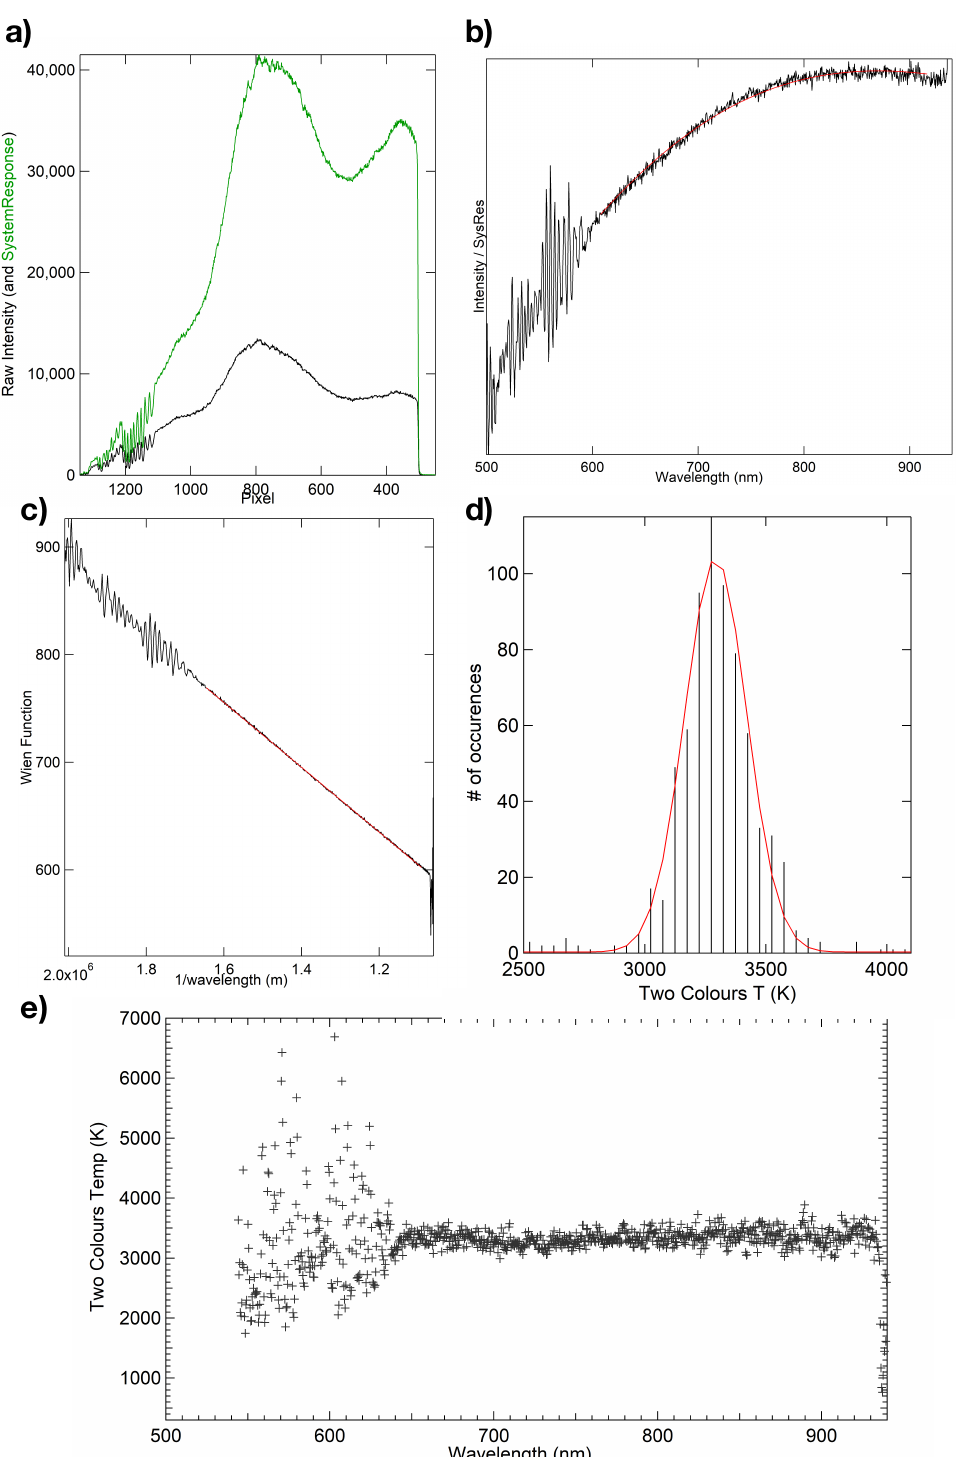
Figure 5. Example of a spectral radiometry temperature measurement obtained around 3300 K. In particular: ( a ) shows the calibrated system response (green) and the raw measurement (black); ( b ) shows the obtained Planck and ( c ) Wien functions and ( d ) the histogram of the obtained ( e ) two-colors signal. In the graphs, the red lines indicate the region used for the